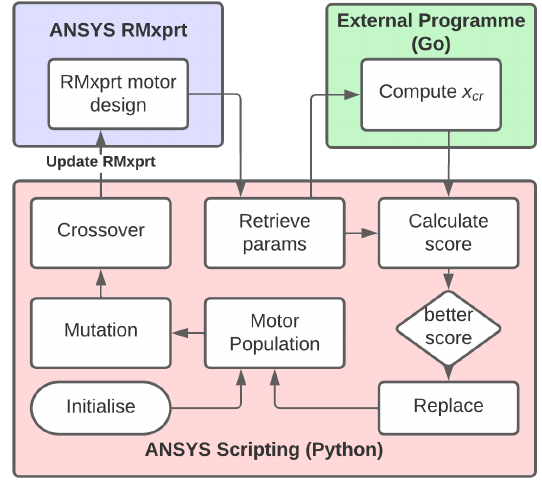
Figure 23. The differential evolution